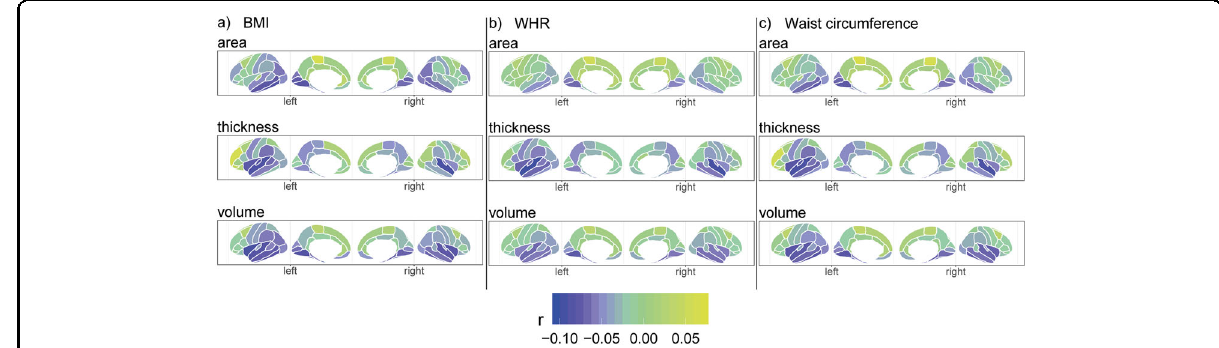
Fig. 3 Linear body – brain association patterns across cortical parcellations for anthropometric measures ( n = 24,728). Results from model 2c that investigates body – brain connections through the inclusion of linear and quadratic terms of anthropometric measures, here showing the results of the linear term for ( a ) BMI, ( b ) WHR, and ( c ) waist circumference. The regression model was adjusted for age, age 2 , sex, age-by-sex, age 2 -by-sex, intracranial volume (except cortical thickness), lifestyle/metabolic factors, Euler number, and site. Figure was created using the ggseg 85 R function. BMI body mass index, r partial correlation coef fi cient, WHR waist-to-hip